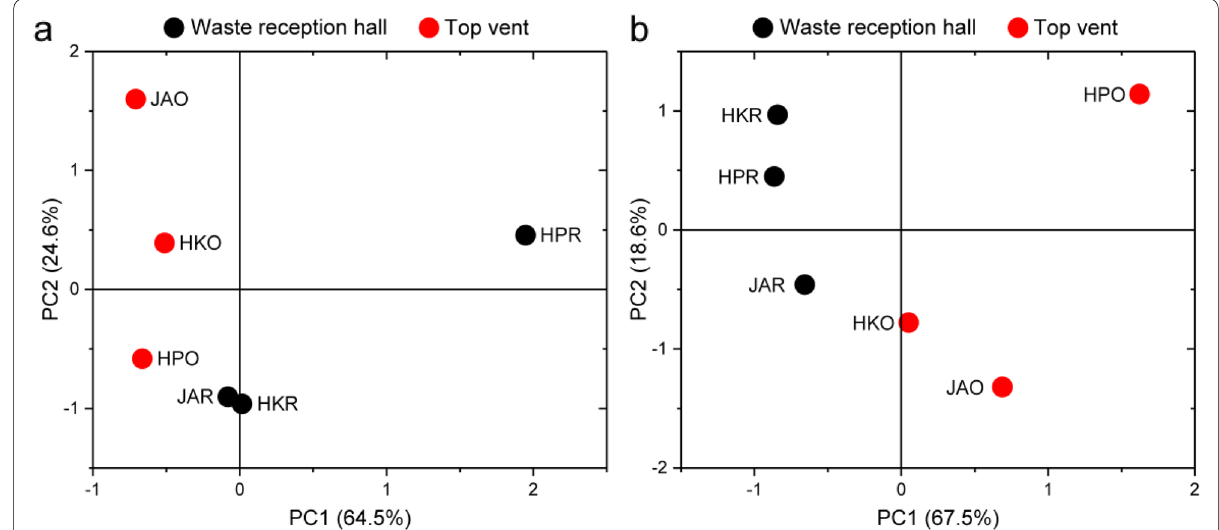
Fig. 3 PCA of prokaryotic (a) and fungal (b) community composition at the genus